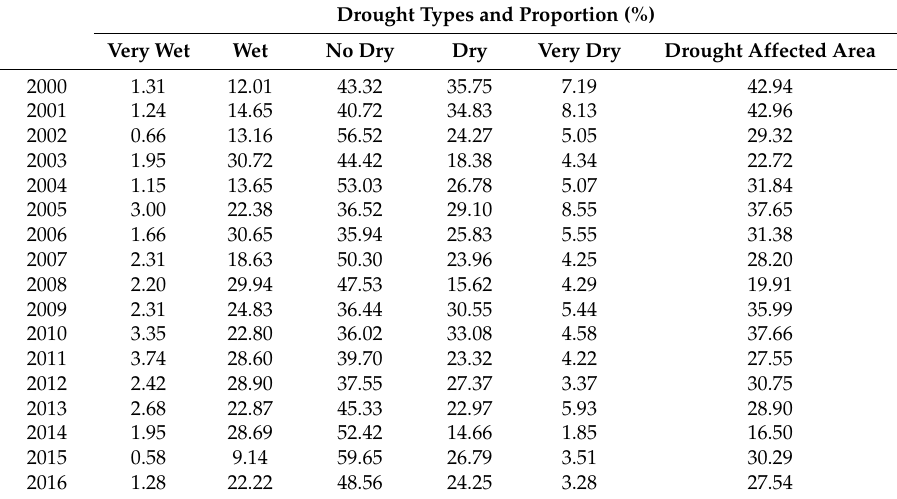
Table 1. The proportion of drought types in the Shaanxi province between 2000 to 2016. Drought Types and Proportion (%) Very